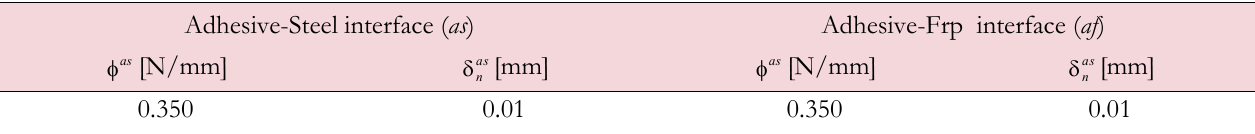
Table 6: Interfaces parameters of the Adhesive-Steel interface ( as ) and Adhesive-Frp interface ( af